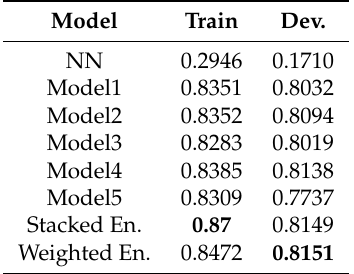
Table 2. Accuracy score for SEM2018.